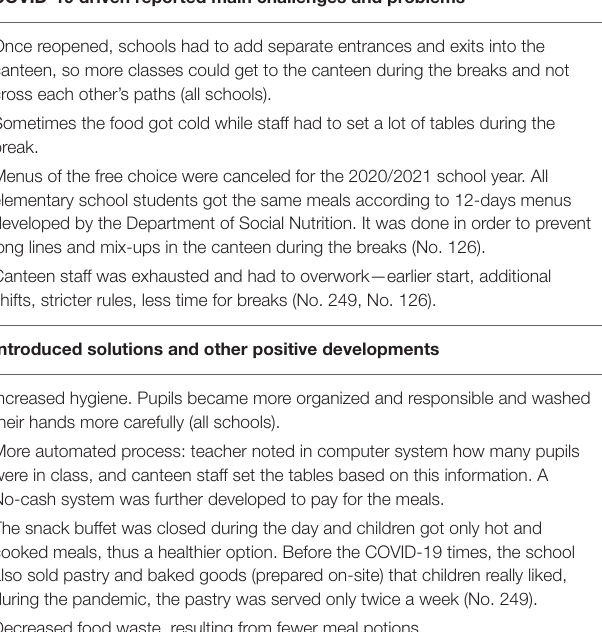
TABLE 6 | Challenges and positive developments during COVID-19 in Saint-Petersburg schools. COVID-19 driven reported main challenges and problems